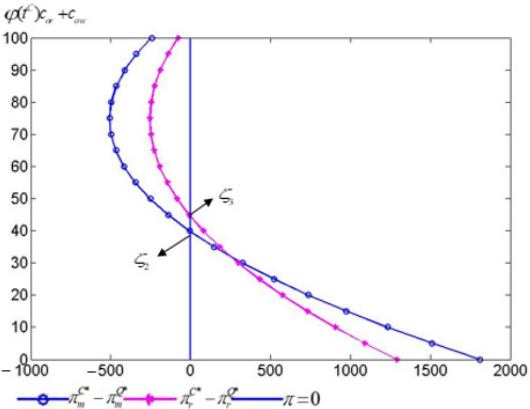
Figure 8. Investment conditions of chain members in the C situation.